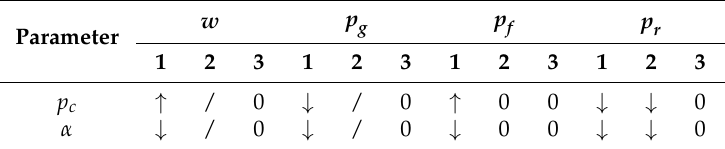
Table 3. The impact of environmental awareness on the change rate in the price.